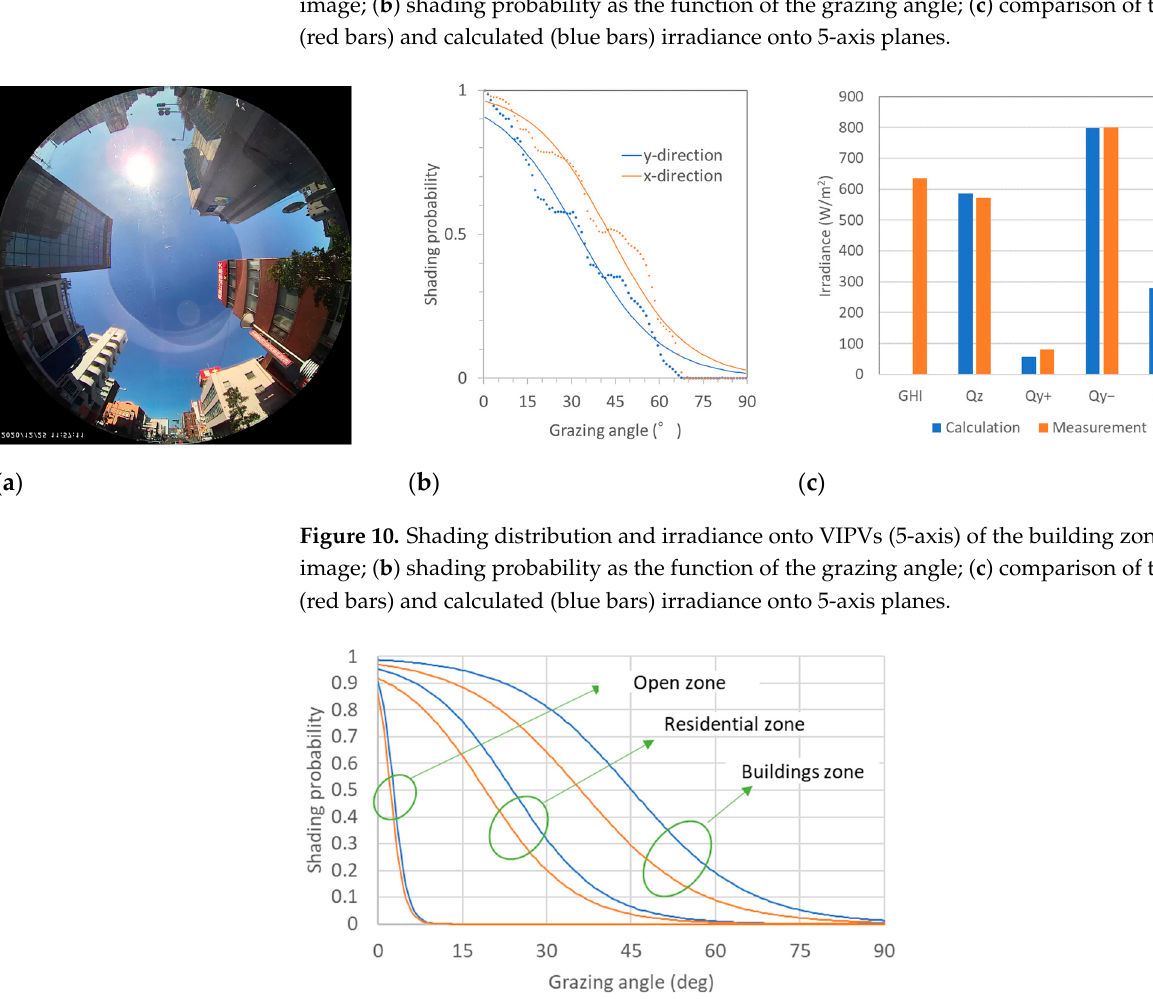
Figure 11. Shading distribution on three zones used for the resilience probability; blue curves correspond to the x-direction (left–right direction), and the red curves correspond to the y-direction (front-rear).